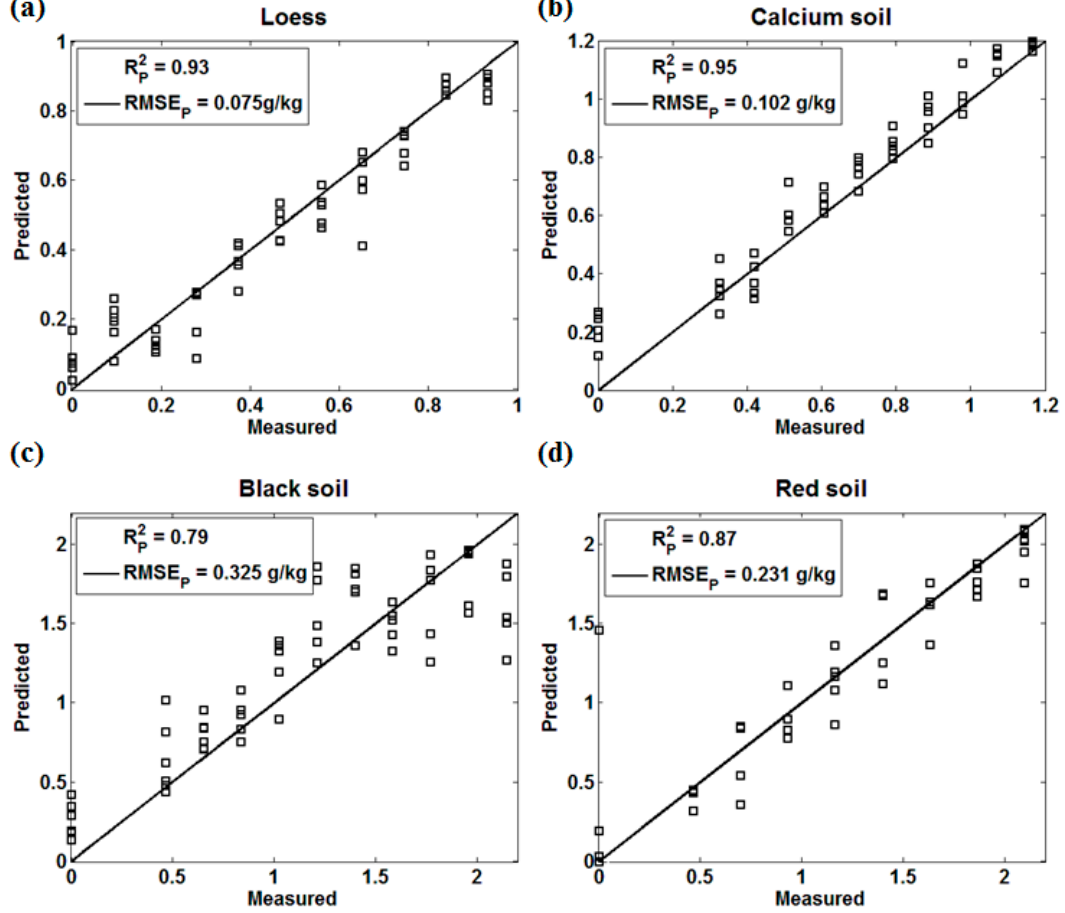
Figure 5. The Back Propagation Neural Network (BPNN) effect of four kinds of soils ( a ) Loess; ( b ) Calcium soil; ( c ) Black Soil; ( d ) Red soil.